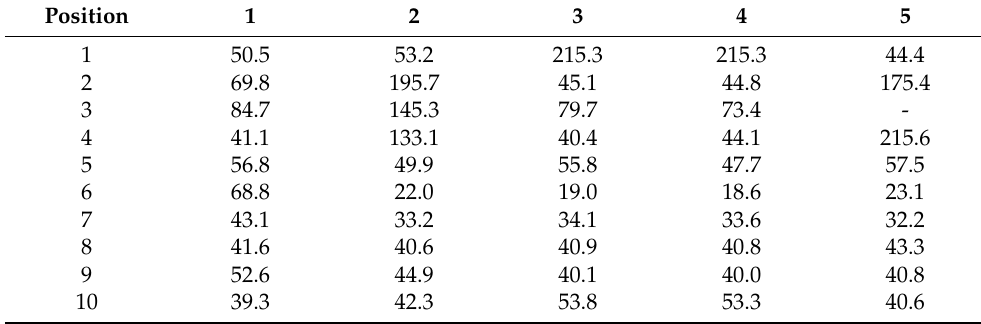
Table 2. 13 C NMR data (125 MHz) for compounds 1 – 5 ( δ , ppm, J , Hz) in CD 3